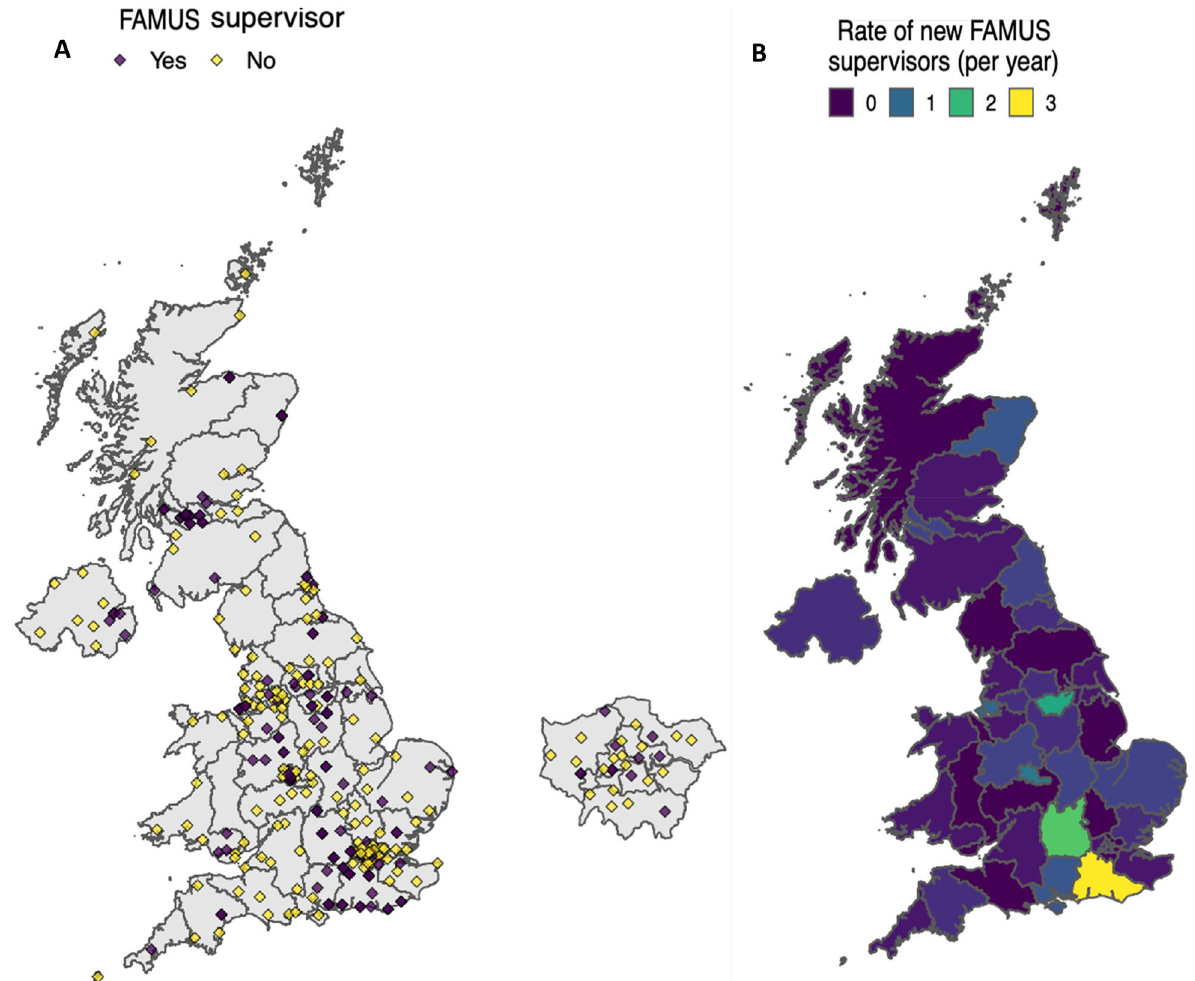
Fig. 5 Geographical distribution of FAMUS supervisors in the UK. A All hospitals in the UK with a type 1 ED stratified by the presence of at least one FAMUS supervisors. B Regional variation in the growth rate of FAMUS